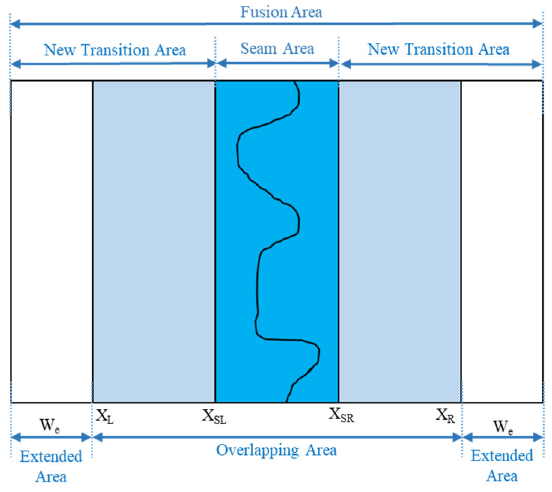
Figure 4. The schematic diagram of the fusion area’s construction.